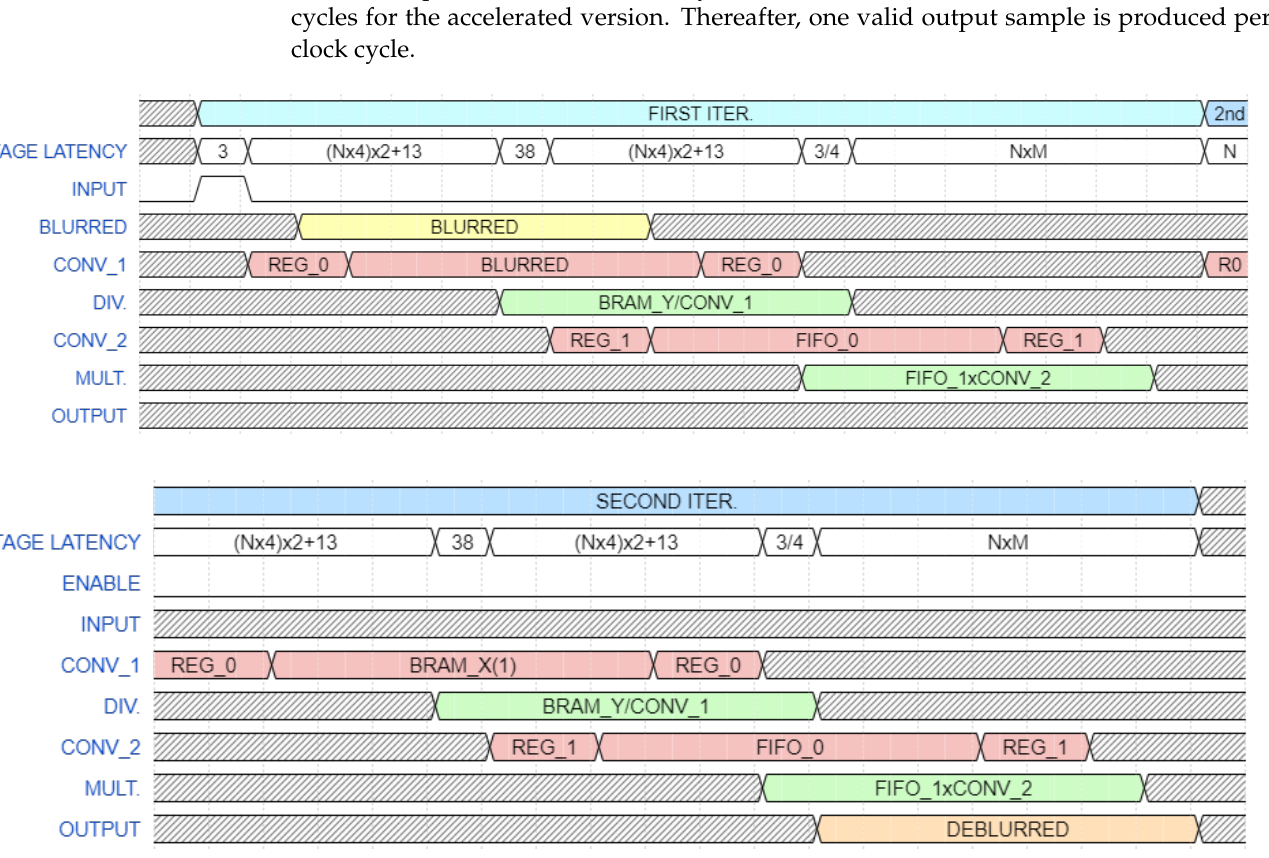
Figure 16. A timing diagram representing two iterations of the RL deconvolution